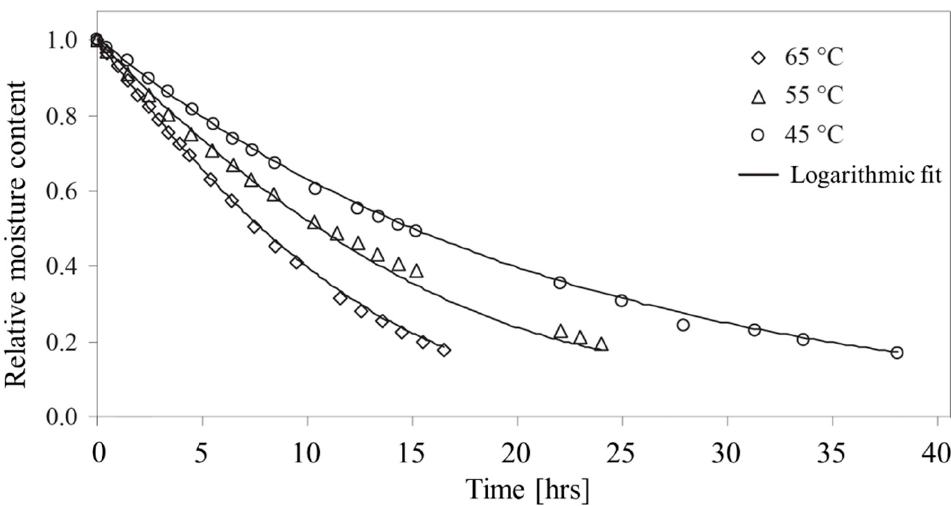
Figure 15. Ear-corn dry-basis relative moisture content as a function of drying time at 3 different temperatures. A logarithmic model was fitted to data yielding determination coefficients of 0.999 in all three cases. Modified from Corrêa et al. [170] .